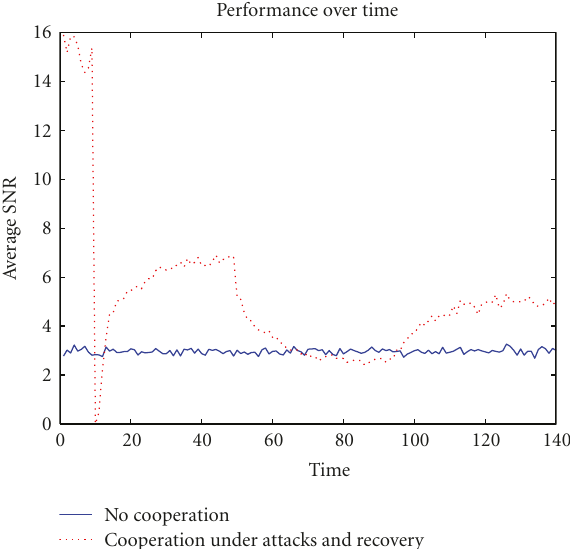
Figure 4: Comparison among the proposed schemes, cooperative transmission using MRC, and direction transmission.